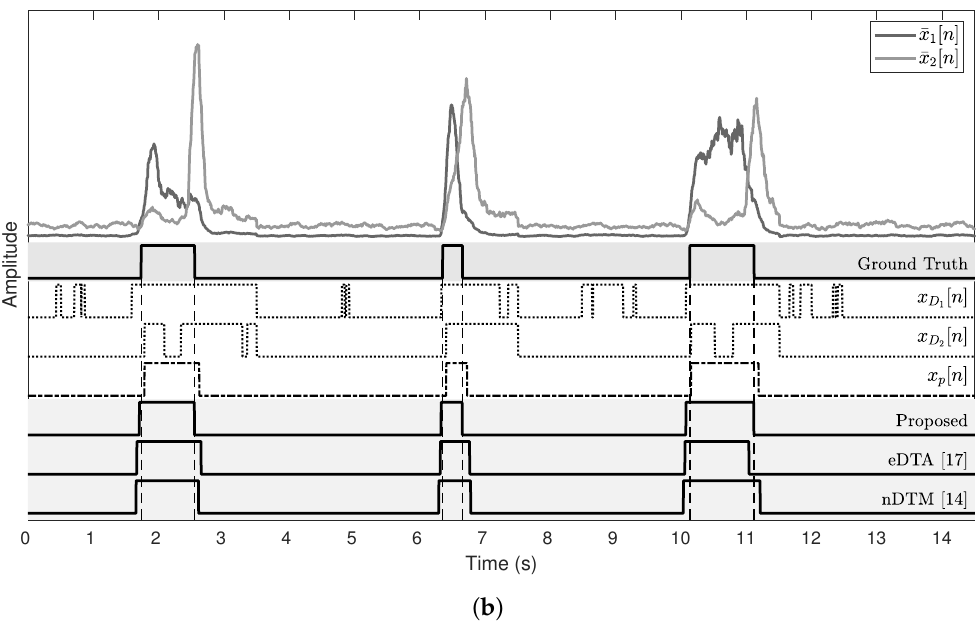
Figure 7. Onset and offset detection results and comparison. ( a ) Onset and offset detection result of subject 1. ( b ) Onset and offset detection result of subject 2.